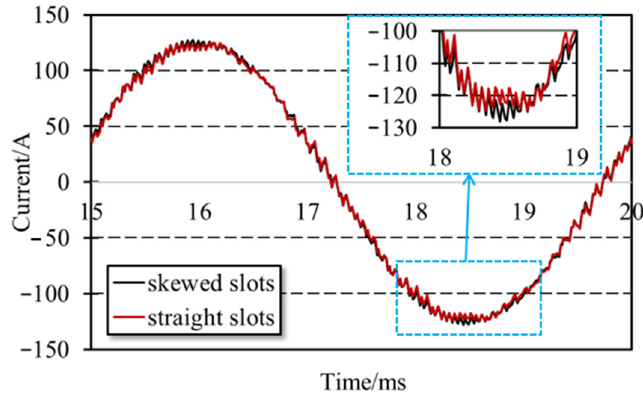
Figure 3. Current waveform at 3000 rpm and rated load .